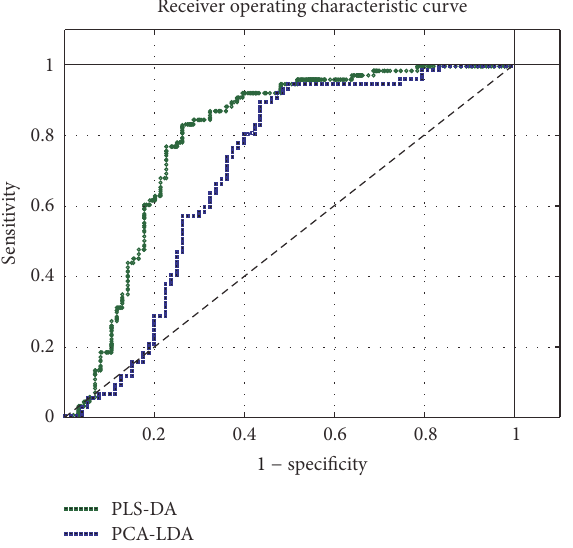
Figure 5: Receiver operating characteristic (ROC) curves of dis- crimination results from Raman spectra for colorectal tissue using Raman spectroscopy and PCA-LDA (blue) and PLS-DA (green) together with the leave-one-patient-out cross-validation